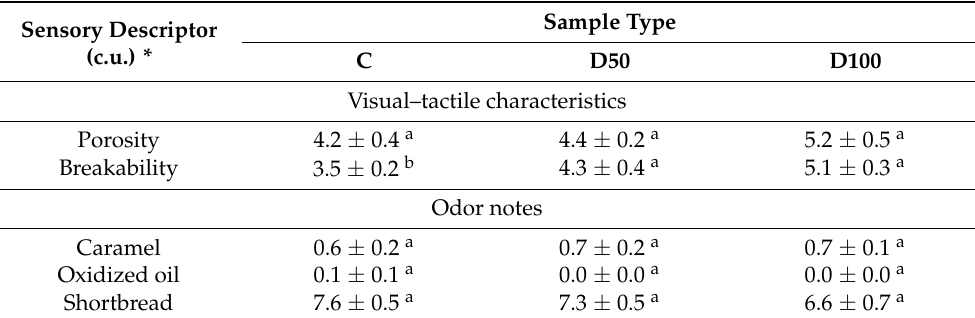
Table 8. Sensory features of the experimental biscuits. C = Biscuits prepared with 100% sunflower oil; D50 = biscuits prepared with sunflower oil (50%) and durum wheat oil (50%); D100 = biscuits prepared with 100% durum wheat